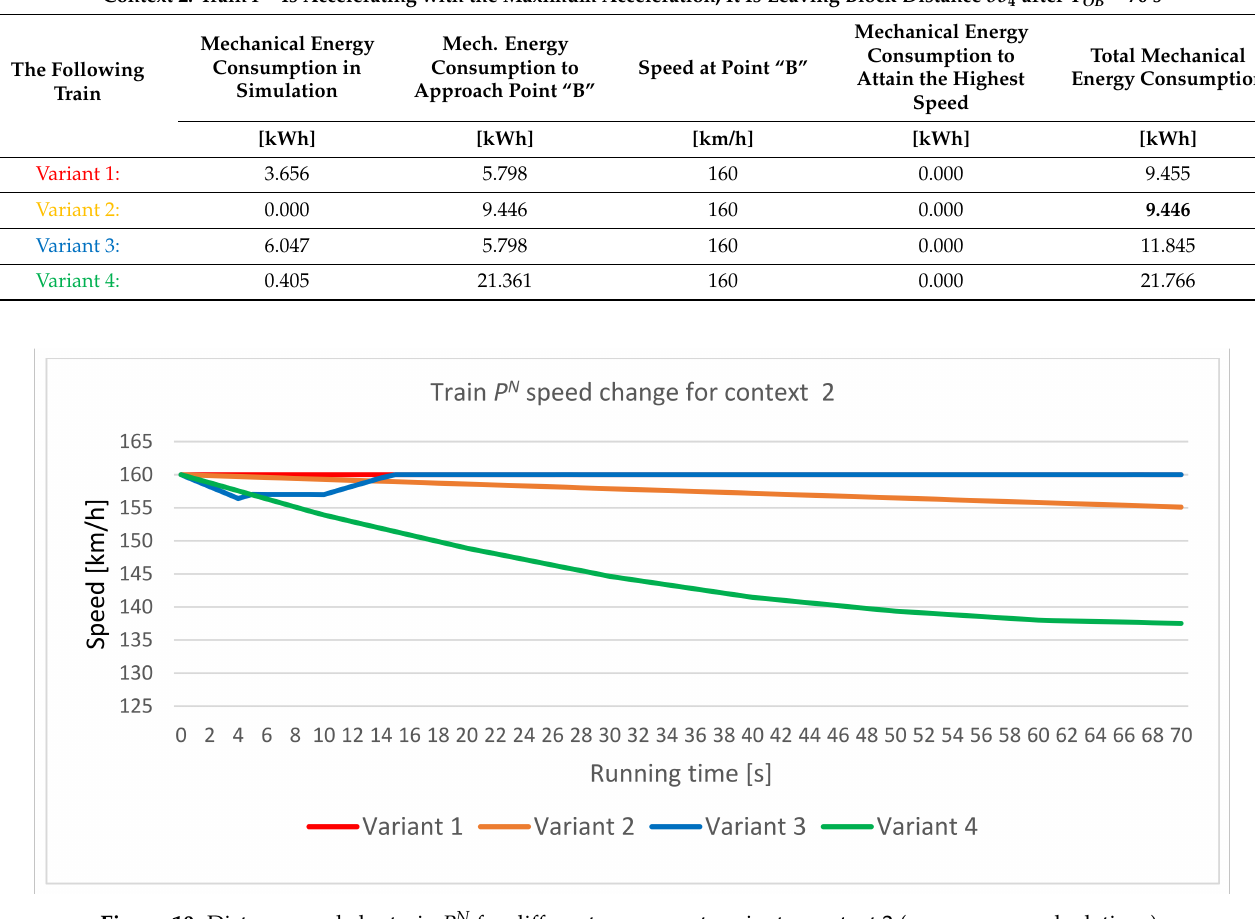
Figure 10. Distance made by train P N for different movement variants; context 2 (source: own calculations).